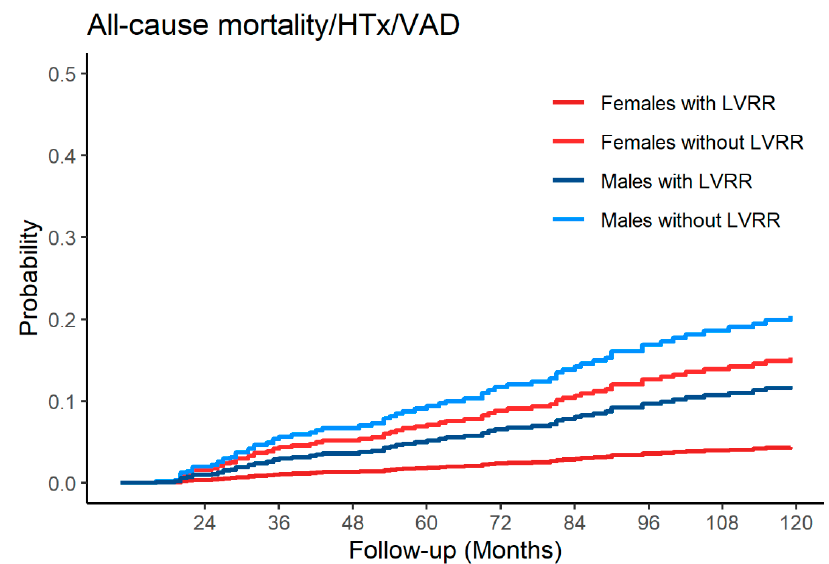
Figure 3. Adjusted Cumulative Incidence estimated from the multi-state model of All-cause mortality/HTx/VAD according to sex in patients with LVRR and without LVRR: Left Ventricular Re. Legend. HTx: Heart Transplantation; VAD: Ventricular Assist Device.